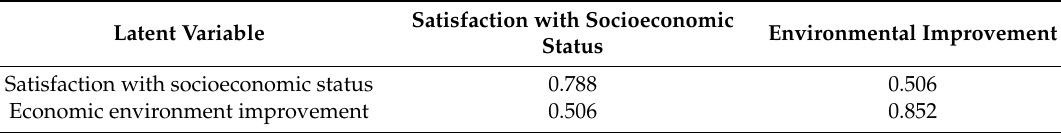
Table 3. Discriminant validity of variable constructs.